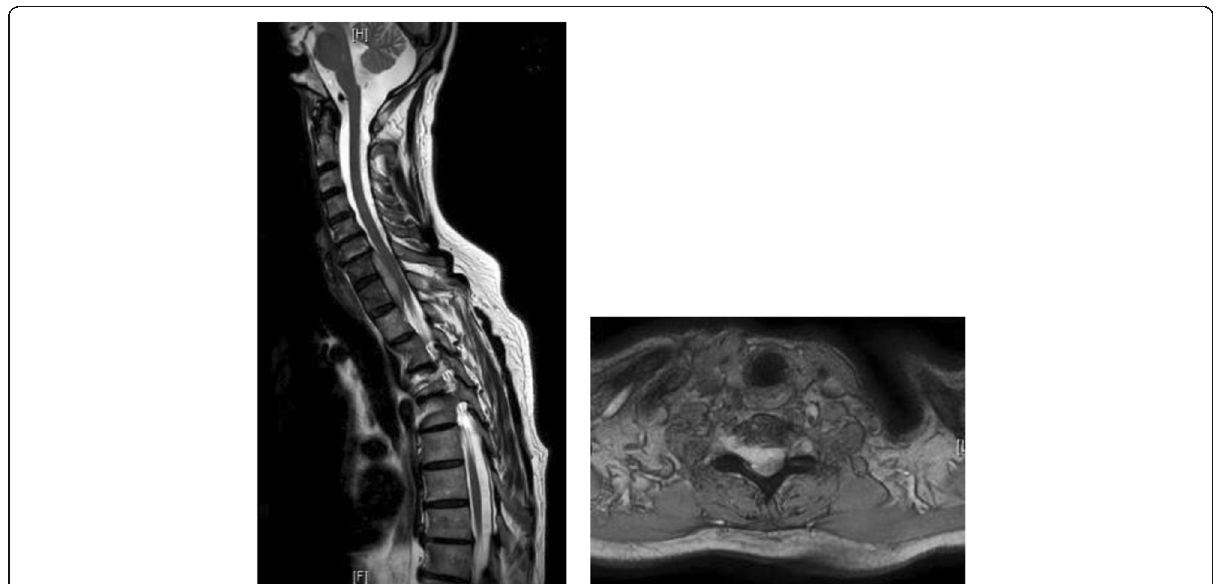
Fig. 1 Sagittal (left) and axial (right) MR images of the cervico-thoracic spine revealing abnormal contrast enhancement of the C6, C7, and T1 vertebral bodies, consistent with osteomyelitis. Additionally, an epidural abscess posterior to the C6 – T1 vertebral bodies caused minimal thecal sac